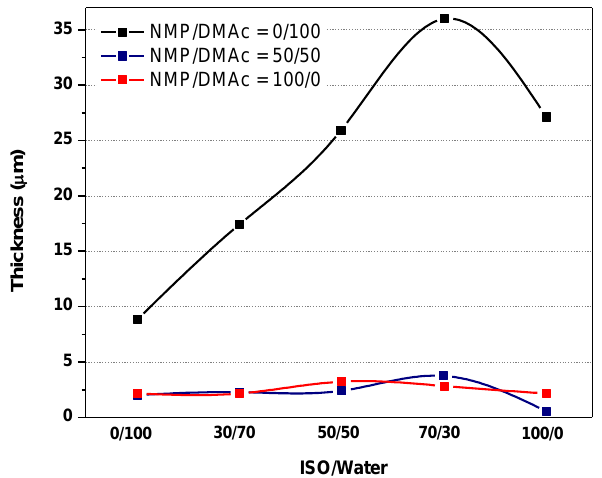
Molecules 2019 , 24 , x FOR PEER REVIEW 9 of 13